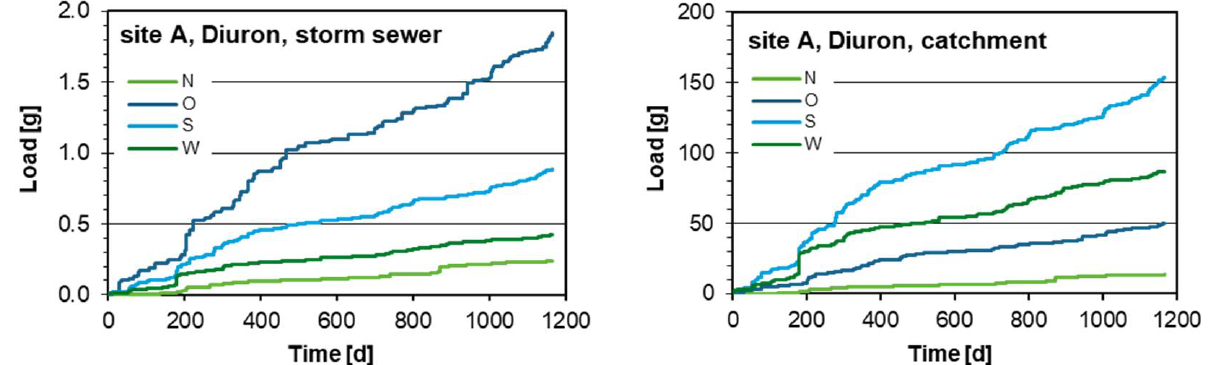
Figure 7. Cumulative exposure-dependent diuron load of all building façades in connection with the storm sewer ( left ) and of all façades of site A ( right ). The scenario-based simulations cover 3 years starting with the construction of the site.